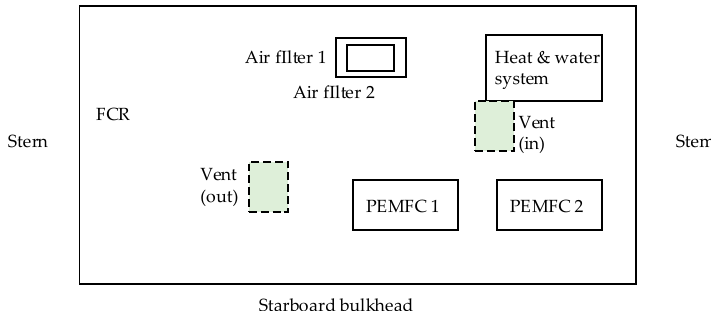
Figure 4. Top view of arrangement in fuel cell room.